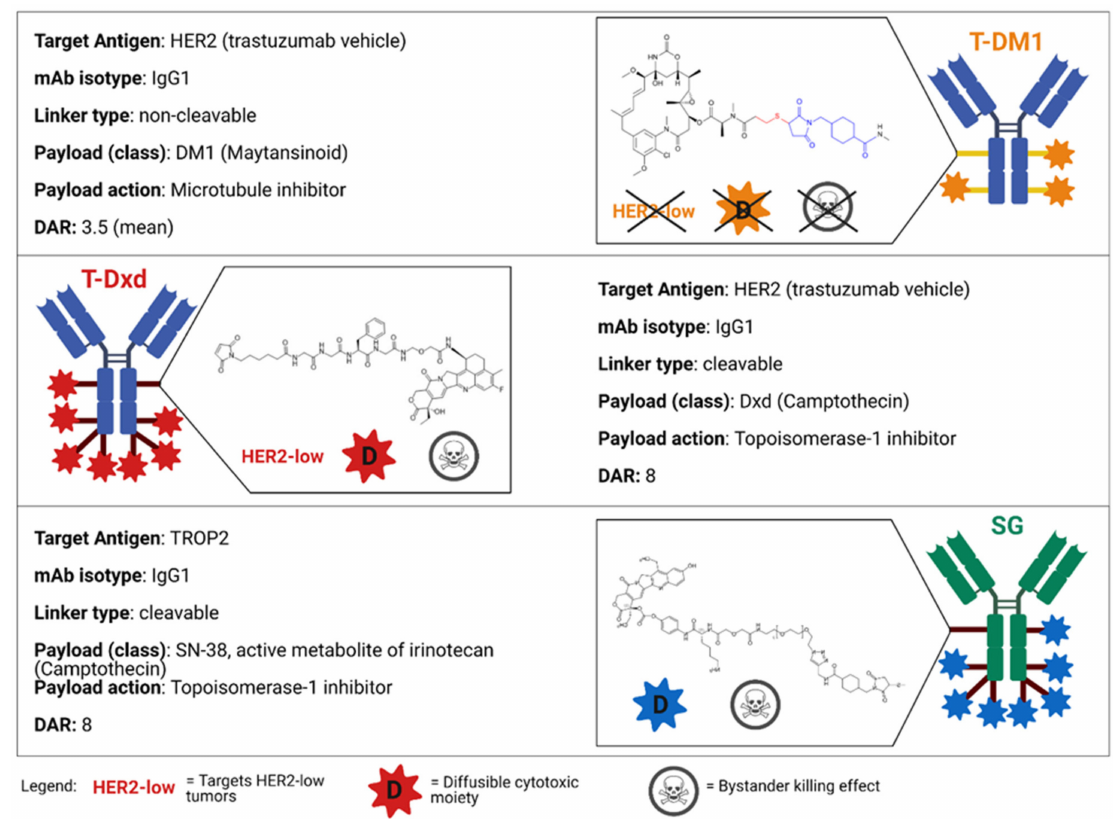
Figure 2. Main features of ADCs currently FDA-approved for the treatment of BC. Abbreviations: T-DM1, trastuzumab emtansine; T-DXd, trastuzumab deruxtecan; SG, Sacituzumab govitecan; HER2, human epidermal growth factor receptor 2; mAb, monoclonal antibody; DAR, drug-to-antibody ratio; DM1, emtansine; DxD, deruxtecan; TROP2, Trophoblast cell surface antigen 2; TNBC, triple-negative breast cancer. Created with Biorender.com (accessed on 15 March